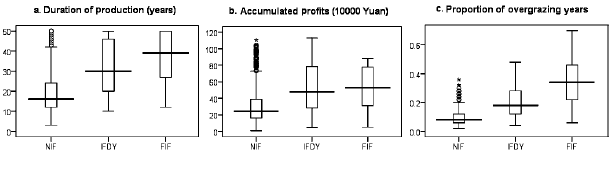
Fig. 4 . Outcomes of different fodder strategies with the baseline scenario. NIF - no import of fodder, IFDY - import fodder only in disaster years, FIF - frequent import of